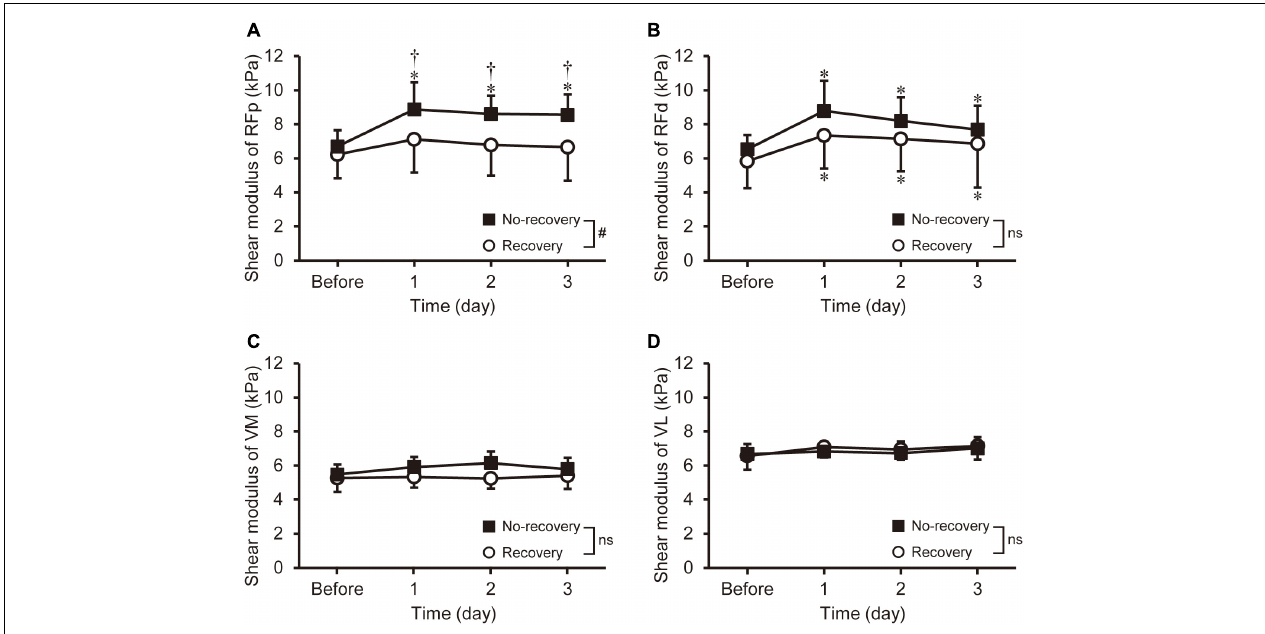
FIGURE 3 | Changes (mean ± SD) in shear modulus of the rectus femoris in the proximal and distal regions (RFp: A and RFd: B ), vastus medialis (VM: C ), and vastus lateralis (VL: D ) before and 1–3 days after eccentric exercise for the recovery and no-recovery groups. * Indicates a significant difference from baseline. † Shows a significant difference between groups. # Demonstrates a significant interaction effect. ns shows no significant interaction